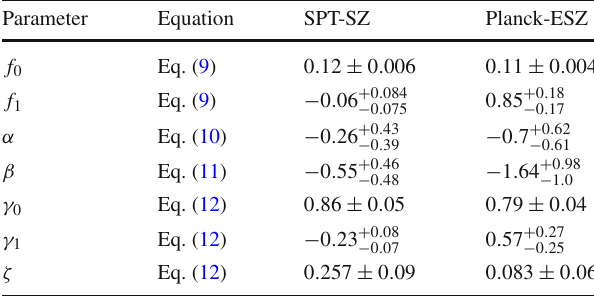
Table 3 Constraints on the parameters of various extended tests of the gas depletion factors as discussed in Sect. 5 for both SPT and Planck